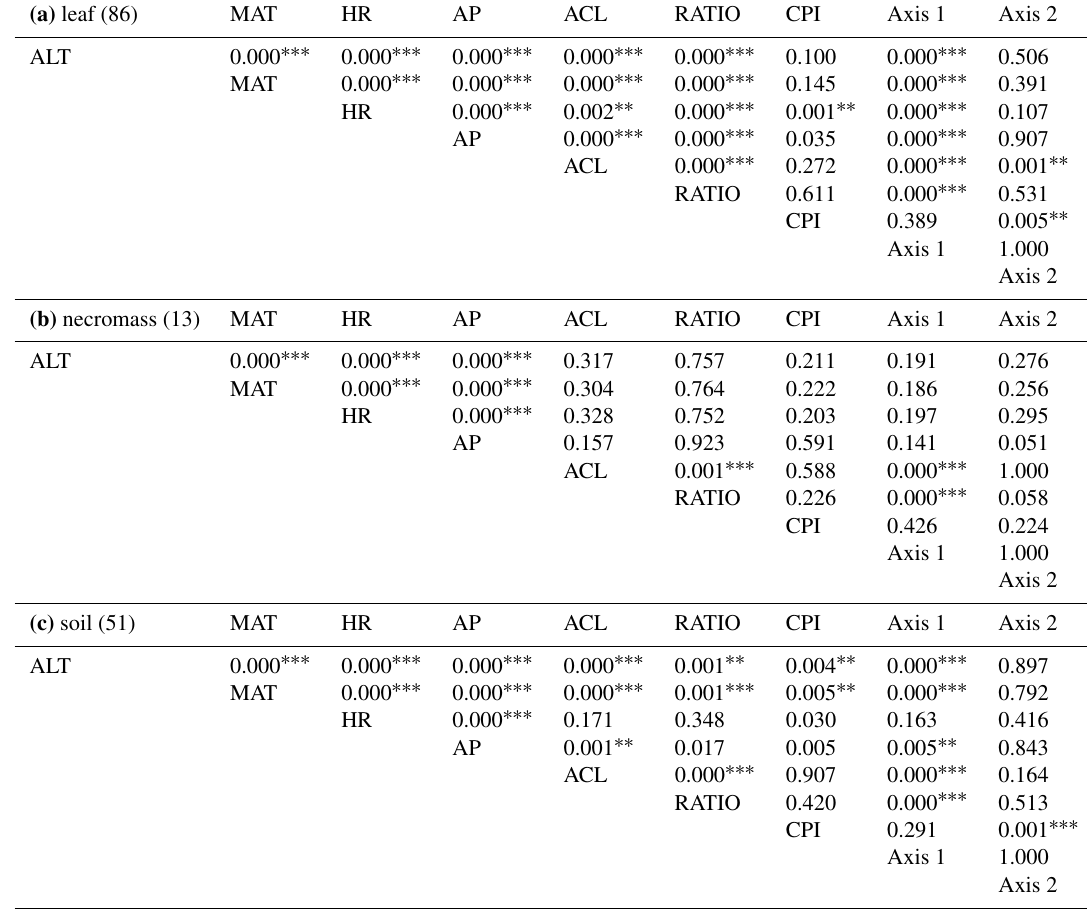
Table 2. Table containing the p values of the Pearson’s correlation coefficients depicted in Figs. 4 and 5. Per sample type (a, b, c) , the correlated variables are altitude (ALT), temperature (MAT), humidity (HR), average chain length (ACL), ratio C 31 / (C 31 + C 29 ) (RATIO), carbon preference index (CPI), and the two axes of the nMDS analysis of each sample type (Axis 1, Axis